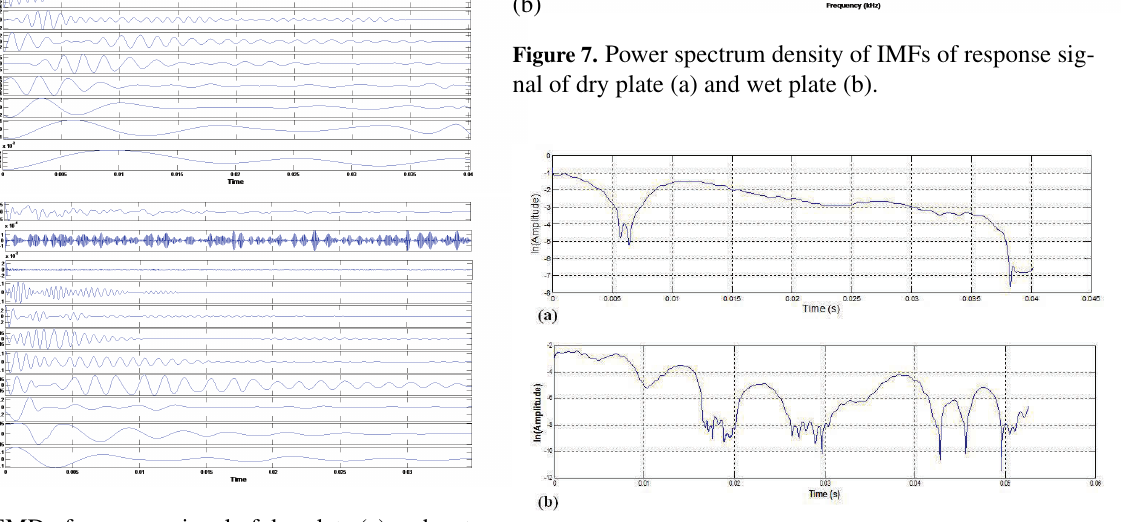
Figure 6. EMD of response signal of dry plate (a) and wet plate (b) (c0: original signal; c1–10: decomposed IMF1- 10).